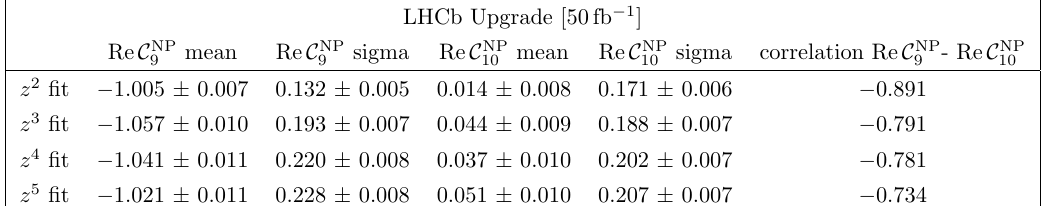
Table 6 . Fit results obtained when (cid:13)oating C NP produced for the BMP scenario with the corresponding statistics expected at the LHCb Upgrade